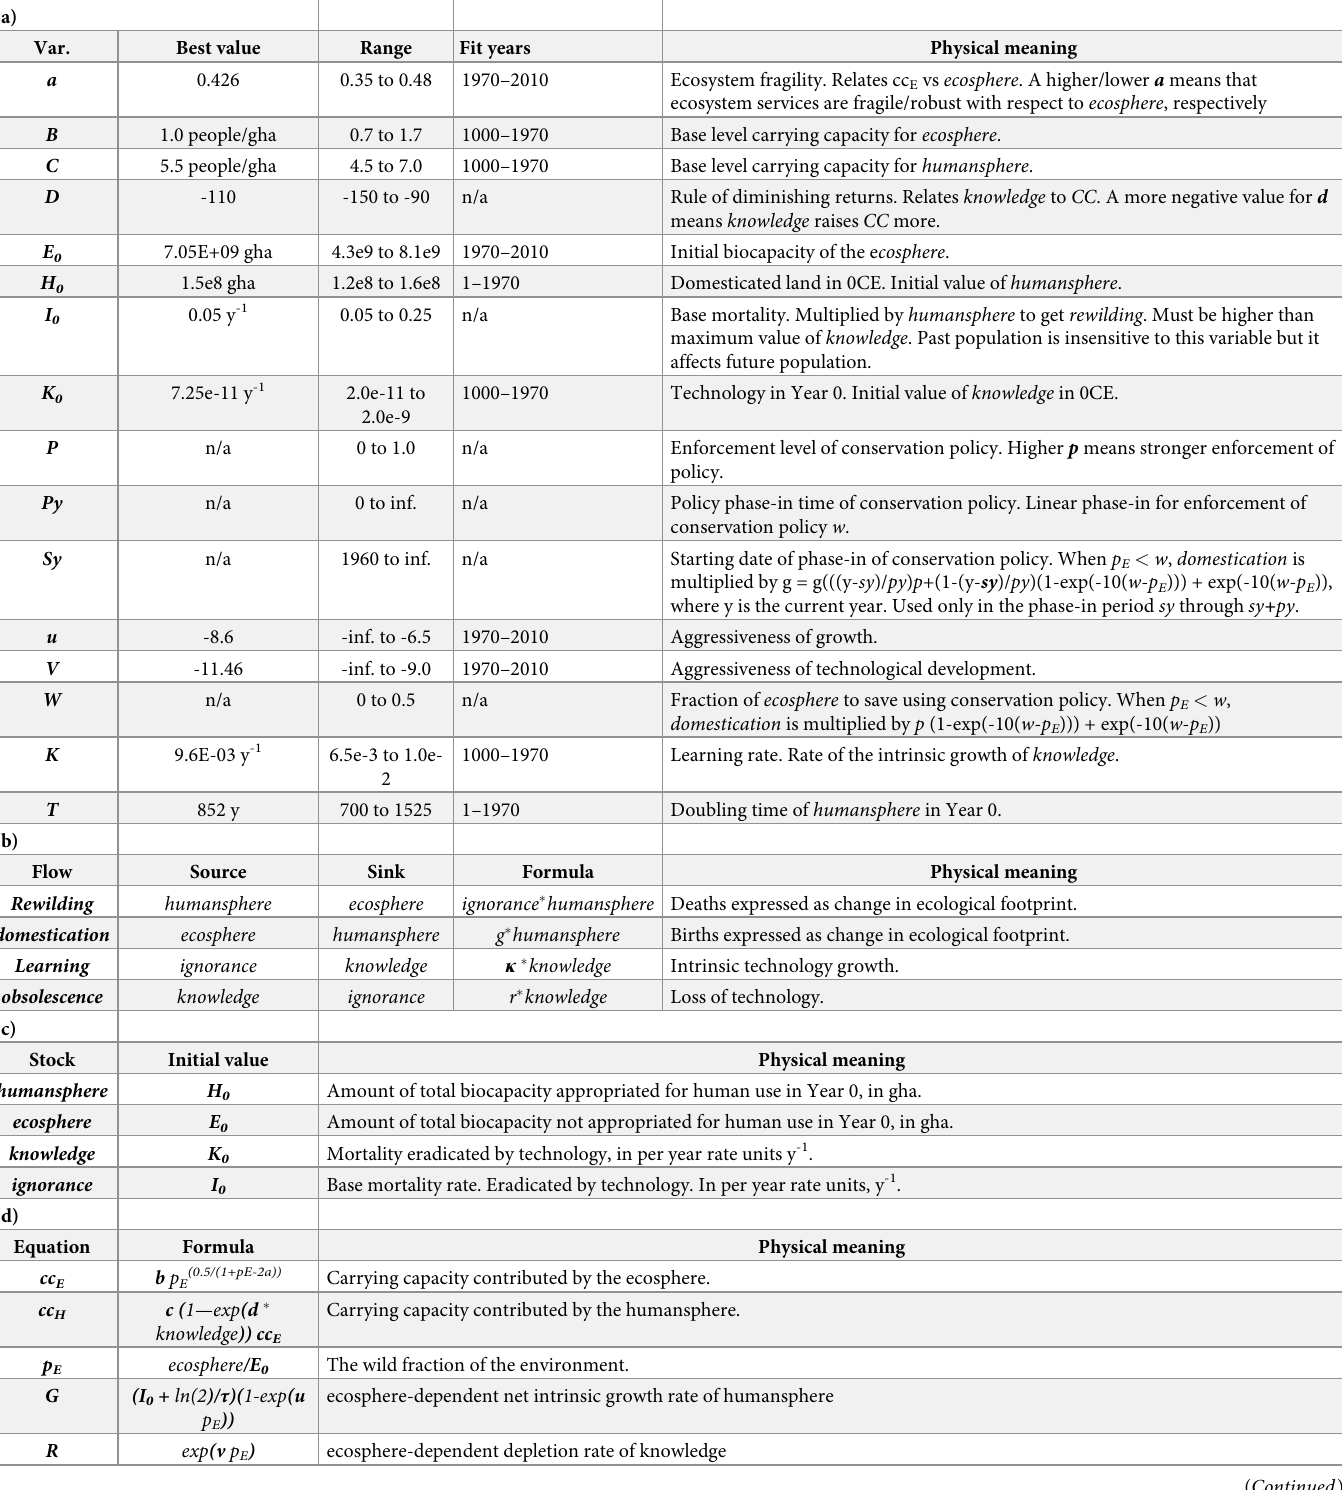
Table 1. Complete component list for World4 model in four parts. (a) Variables. (b) Flows. (c) Stocks. (d) Equations. Variables in bold italics were fit to data. Best value is one solution of many. Range shows values that can be fit to data with less than a specific residual depending on range of years fit. Fit years is the range used for fit- ting in hyperfit